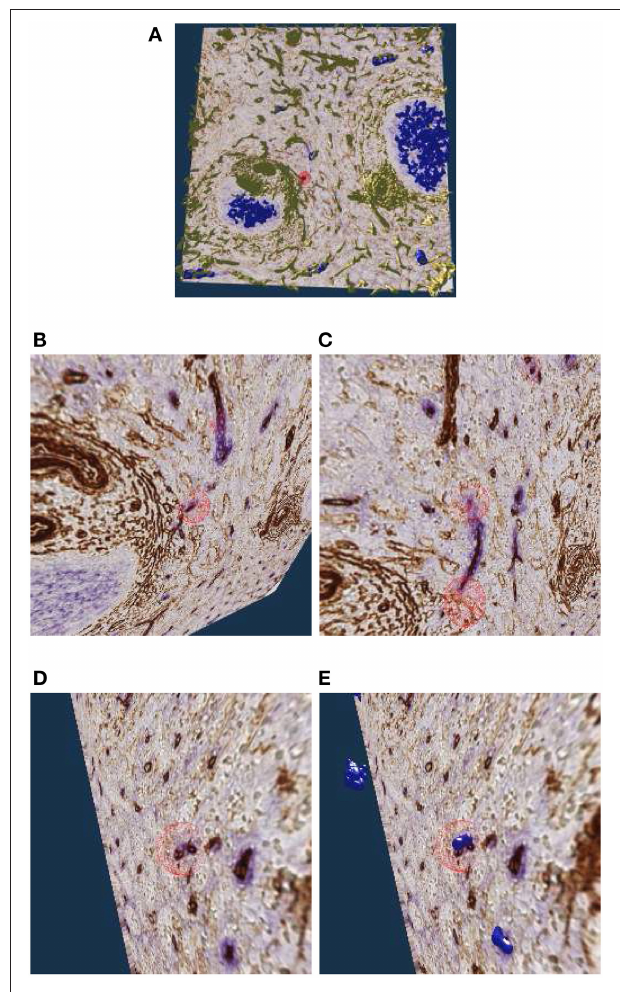
FIGURE 9 | Investigating the annotated regions, VR screenshots of our application.The human spleen “red pulp” data set is used ( Steiniger et al., 2018b); we have annotated some ends of capillary sheaths in meshes reconstructed from human spleen data. (A) Overview. (B–D) Original data and an annotation. Experts can more easily reason on such visualizations because of 3D perception and intuitive navigation. (E) The same annotation as in (D) , showing additionally the mesh for